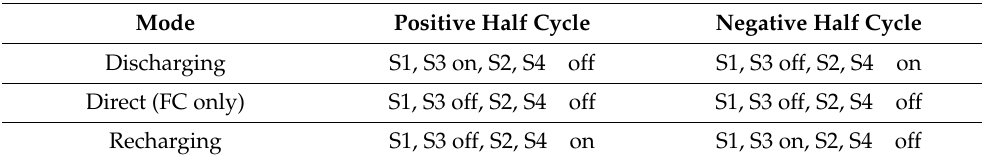
Table 1. Switching